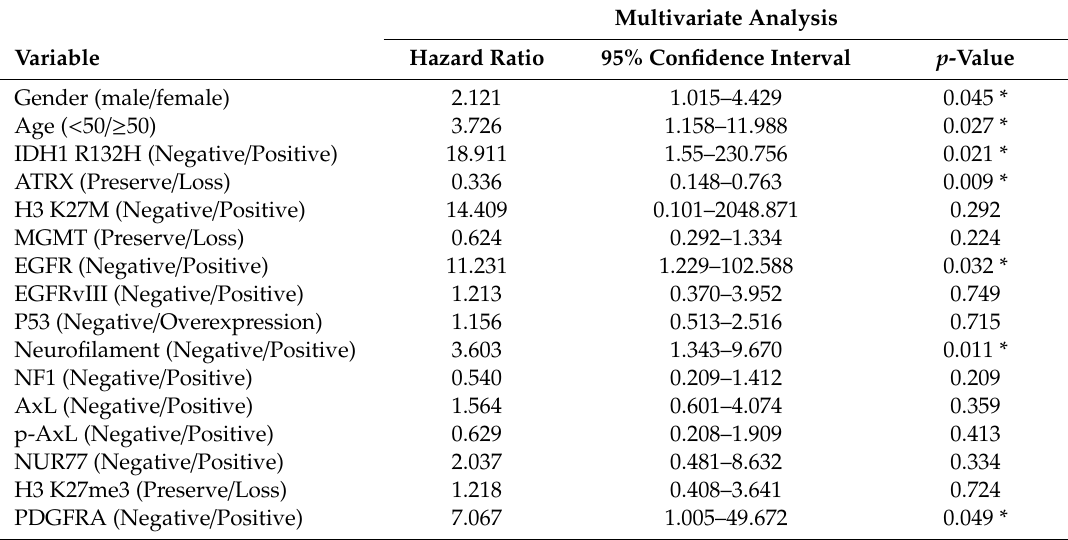
Table 2. Multivariate analyses for various clinical parameters expression in brain